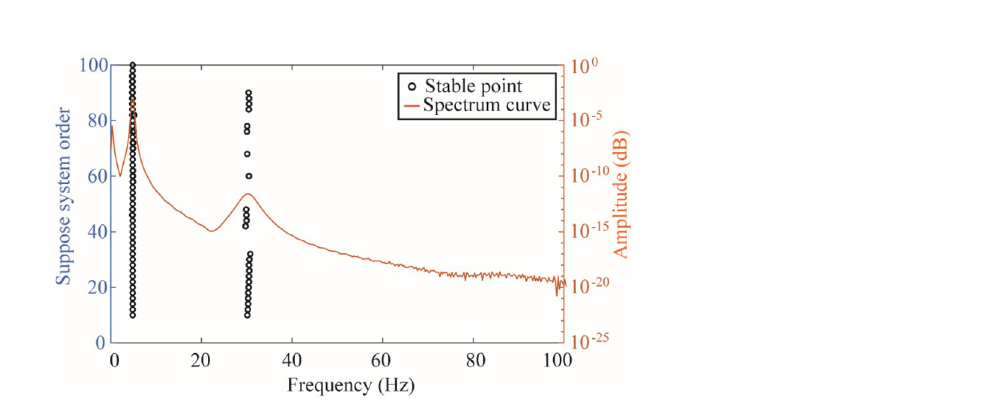
Figure 3. Stability diagram and spectrum